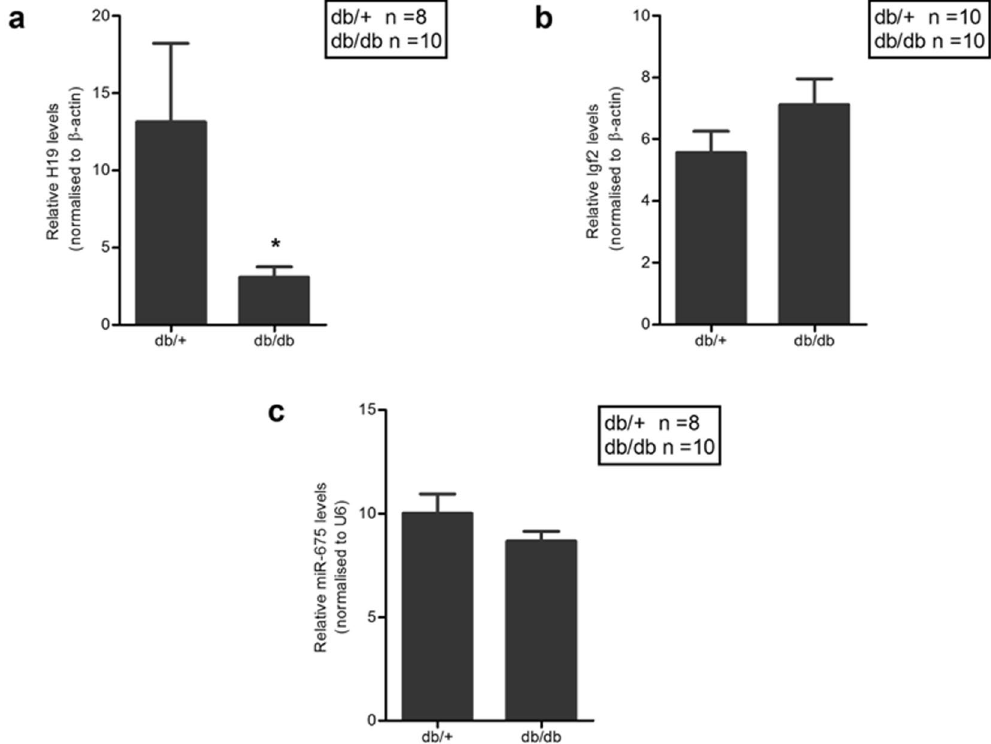
Figure 3. H19 levels are downregulated in the db/db mice liver. ( a ) 1 µ g of total RNA was reverse transcribed and expression levels of H19 lncRNA in the livers of db/ + (n = 8) and db/db (n = 10) mice were quantified by qRT-PCR using specific primers. β -actin was used as a normalization control. ( b ) Expression levels of hepatic Igf2 was quantified in db/ + (n = 10) and db/db (n = 10) mice by qRT-PCR using specific primers. ( c ) 1 µ g of total RNA was reverse transcribed using specific stem loop primers for miR-675 and its expression was quantified in the livers of db/ + (n = 8) and db/db (n = 10) mice. U6 was used as the normalization control. Data presented are means ± s.e.m. * P <